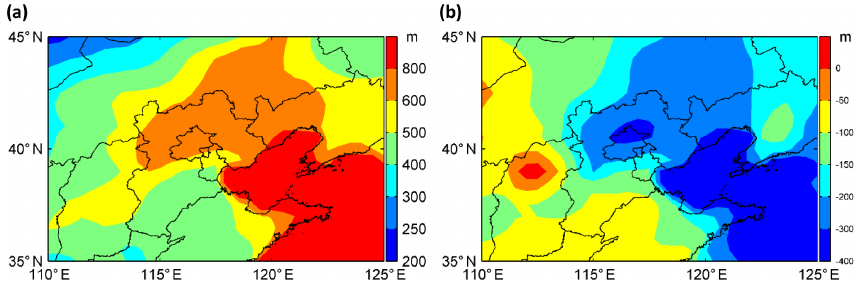
Figure 8. (a) The monthly mean BLH in December 2014 and (b) the change of monthly average BLH in December between 2015 and 2014 over north